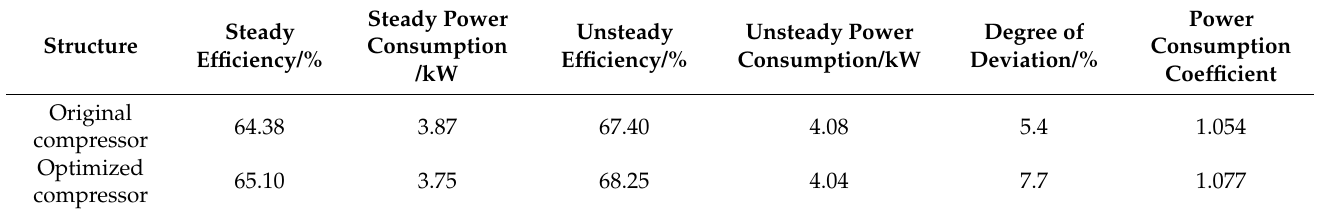
Table 6. Performance comparison of different compressor structures at 150,000 rpm.